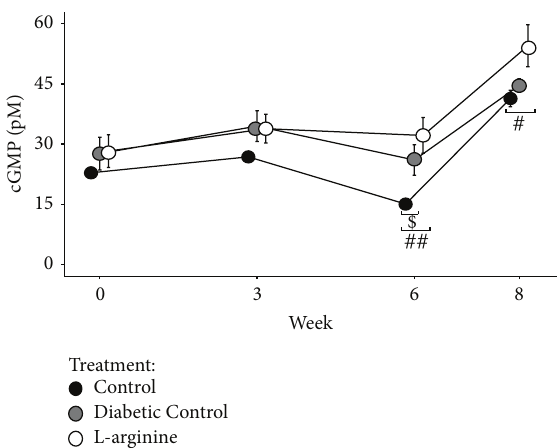
Figure 5: Effect of the high fructose diet alone and high fructose plus L-arginine diet on cGMP levels over 8 weeks. Control versus Diabetic Control: $ 𝑃 < 0.05 ; Control versus L-arginine: # 𝑃 < 0.05 and ## 𝑃 < 0.01 .